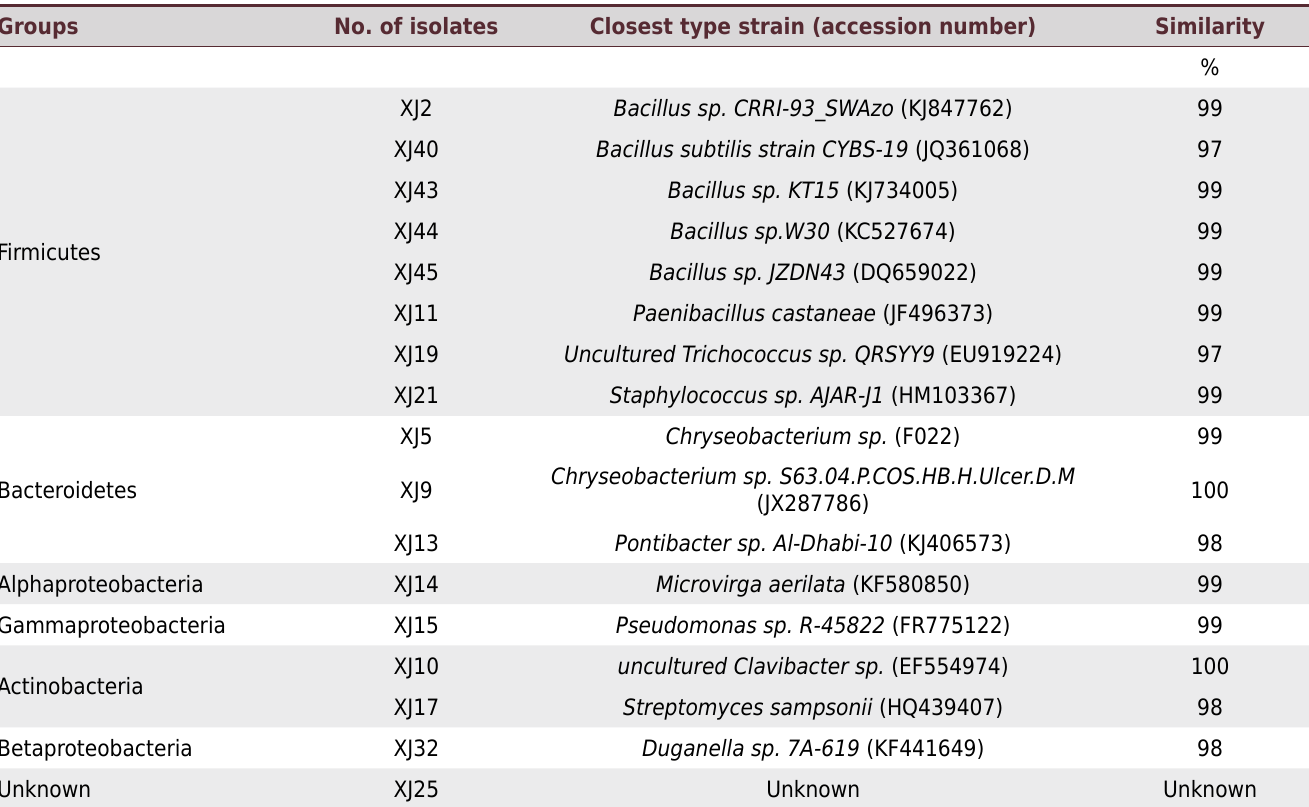
Table 1. Phylogenetic similarity between the cultivable bacteria isolated and their closest type strains